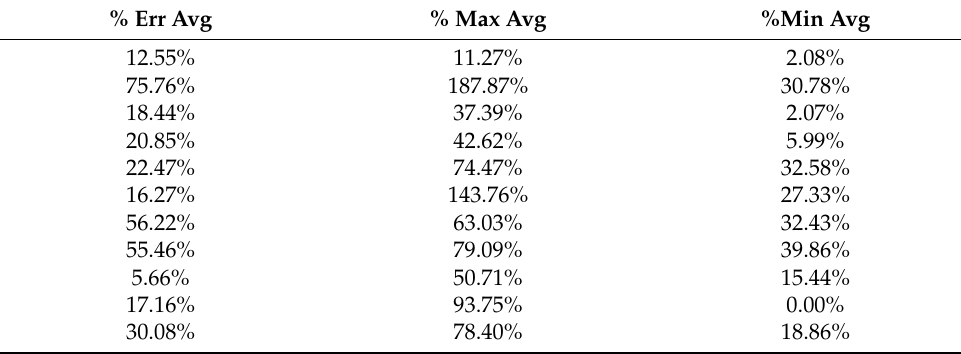
Table A119. Set 2, trials 21–30 data (actual PR